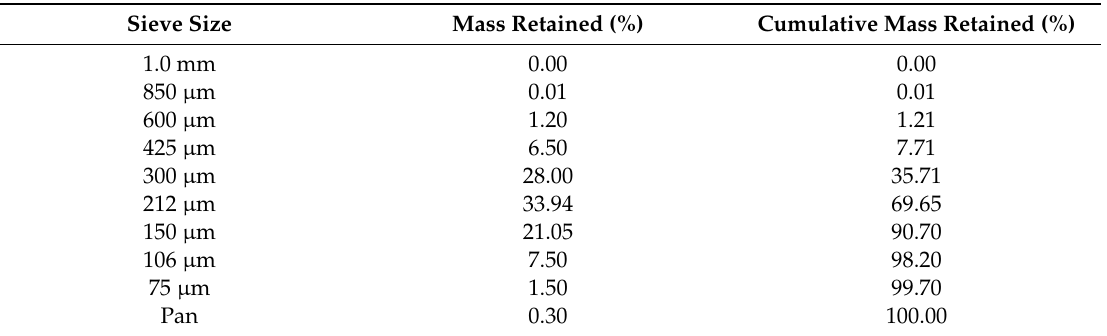
Table 2. Sieve analysis of silica sand